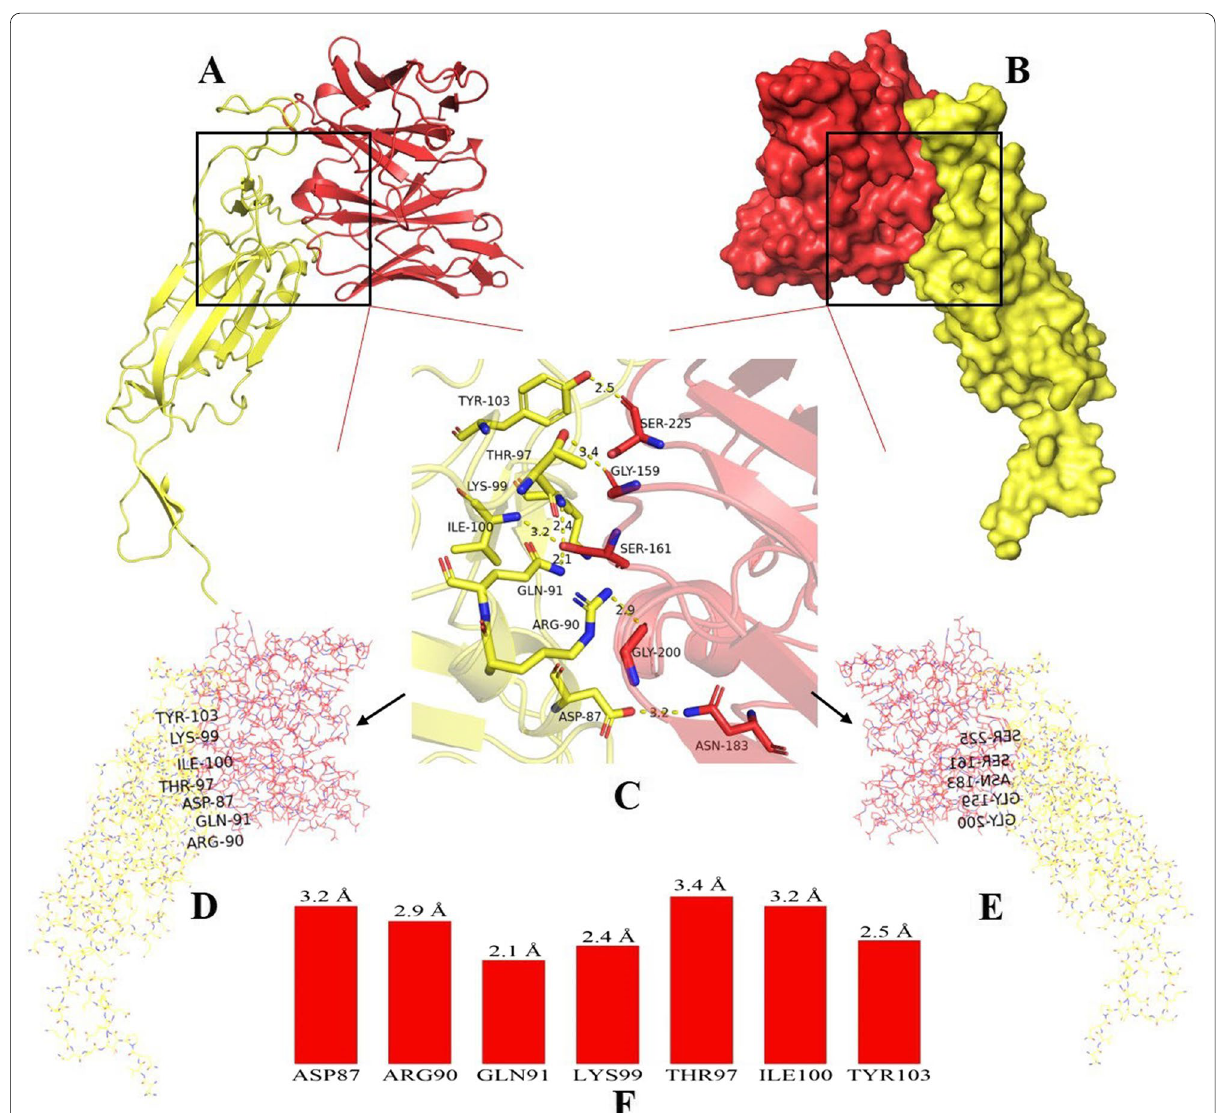
Fig. 8 SARS-CoV-2 S1 protein-IgY scFv interaction and interface characterization. A the interacting interface residues in yellow and red cartoons. B the complex of scFv and RBD in surface view ( yellow and red , respectively). C , D and E the interacting residues are shown: yellow (scFv) and red (RBD). F the interaction energetics quantification of hydrogen bond in scFv